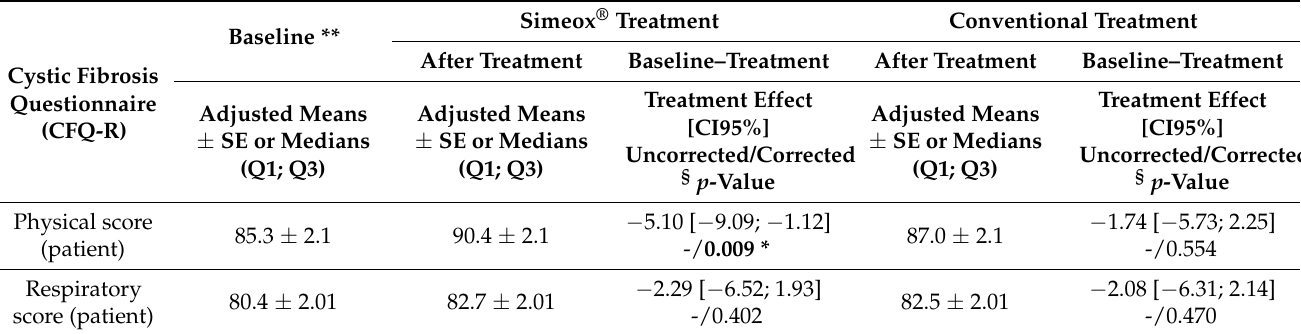
Table 6. Comparisons CFQ-R treatments against